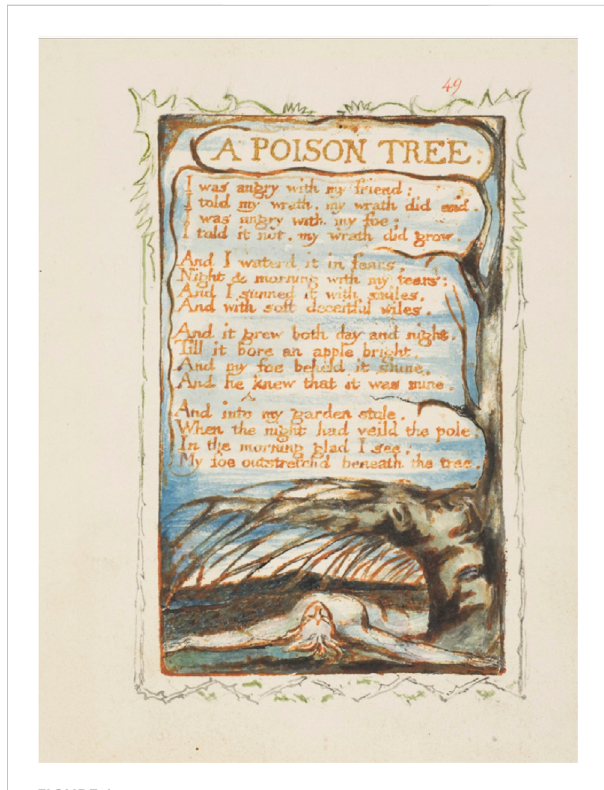
FIGURE 1 Songs of Experience: A Poison Tree. Plate 49. William Blake (British, London 1757-1827). The Metropolitan Museum of Art, New York, Rogers Fund, 1917. www.metmuseum.org. Image obtained under The Met ’ s Open Access